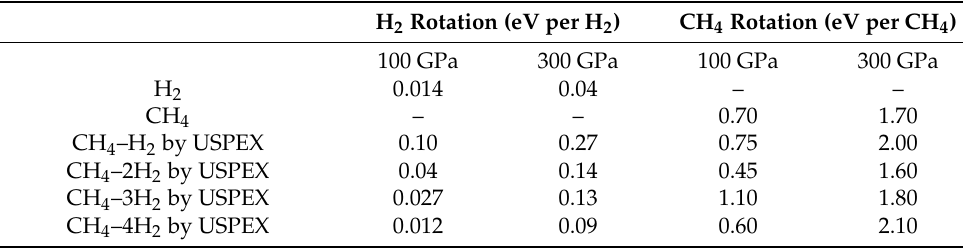
Table 1. The computed barriers of rotation in H 2 and CH n (n ≥ 4) structures.